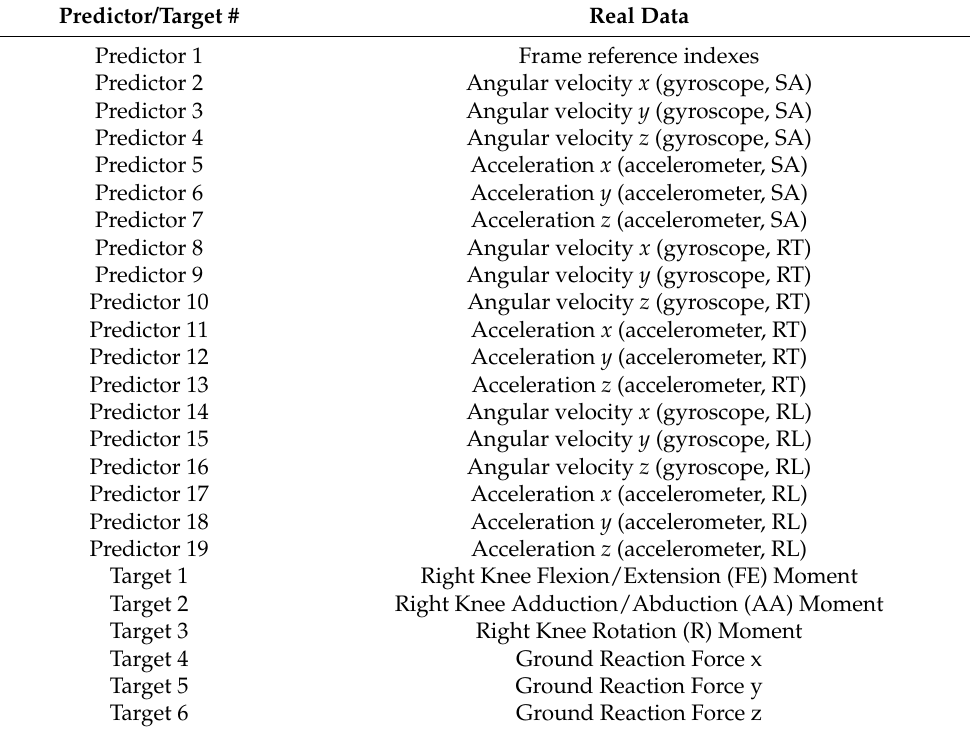
Table 3. Signals fed to the network (inputs or predictors) and outputs (or